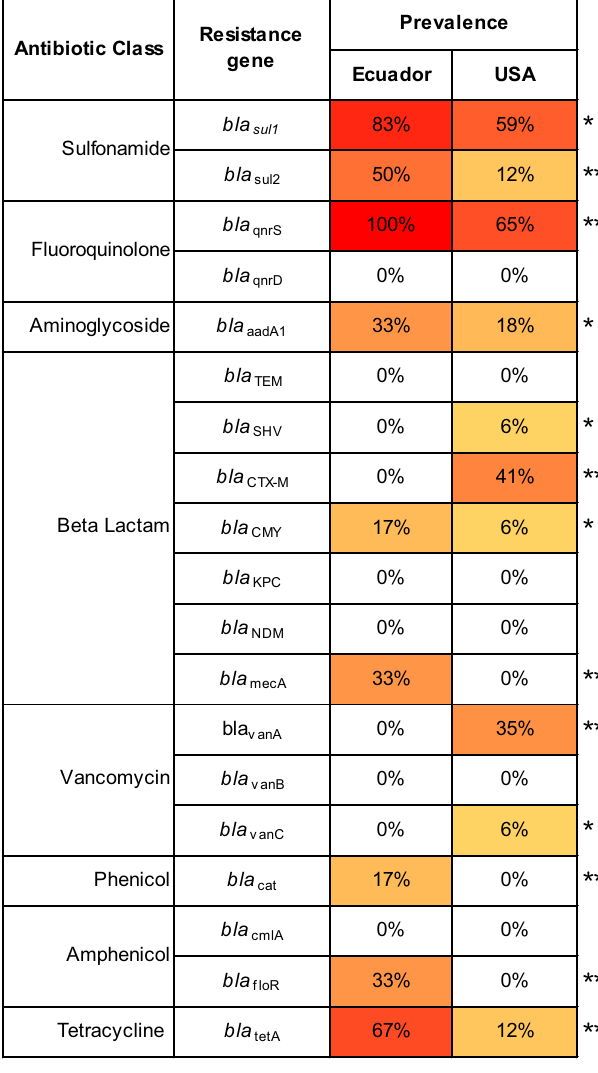
Figure 3. Differences in the prevalence of antibiotic-resistant bacteria in wild-caught (U.S.) versus farm-raised (Ecuador) shrimp. Percentage resistance observed among bacterial genomic DNA isolated from shrimp gut samples by real-time PCR assays. *p < 0.05; **p <